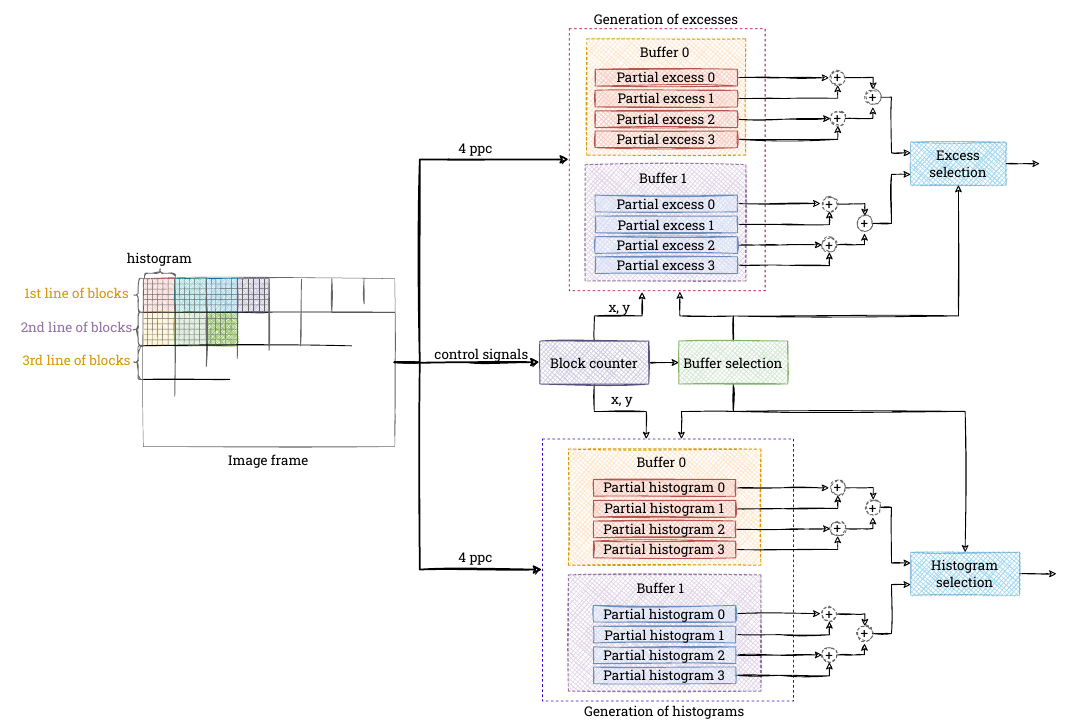
Figure 11. Block diagram of the implemented histograms’ calculation. We use 4 partial histograms and excesses (one for each pixel from the 4 ppc), which are then aggregated by using summation trees. They are grouped into two buffers – one for the odd lines of the image and the other for the even lines. Thanks to that, we can simultaneously read the prepared data from one buffer and perform further calculations using the